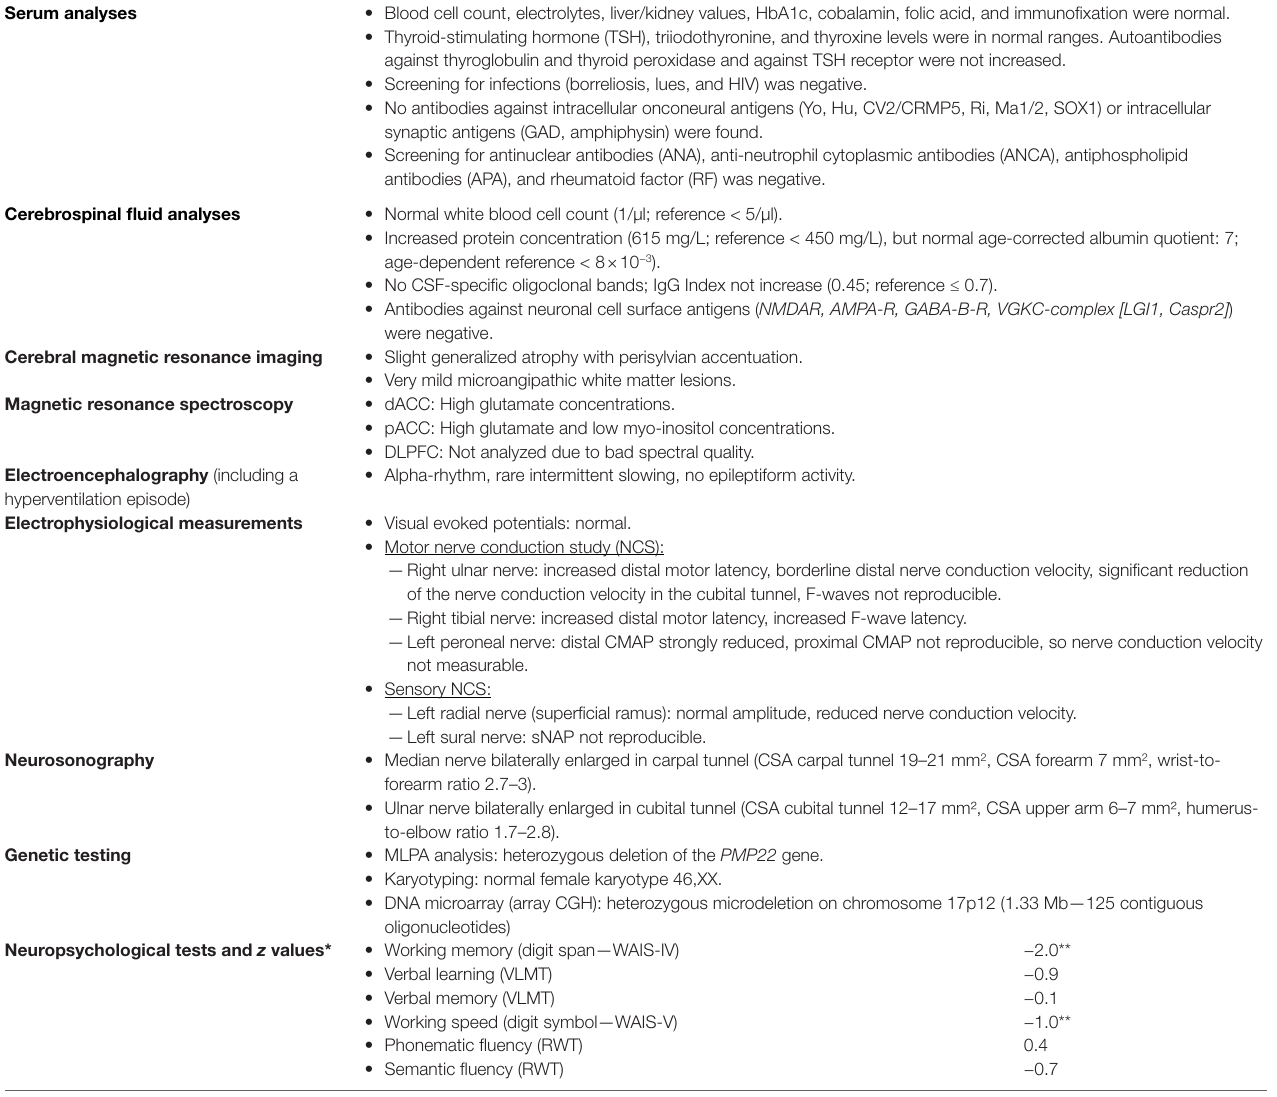
TABLE 1 | Current diagnostic